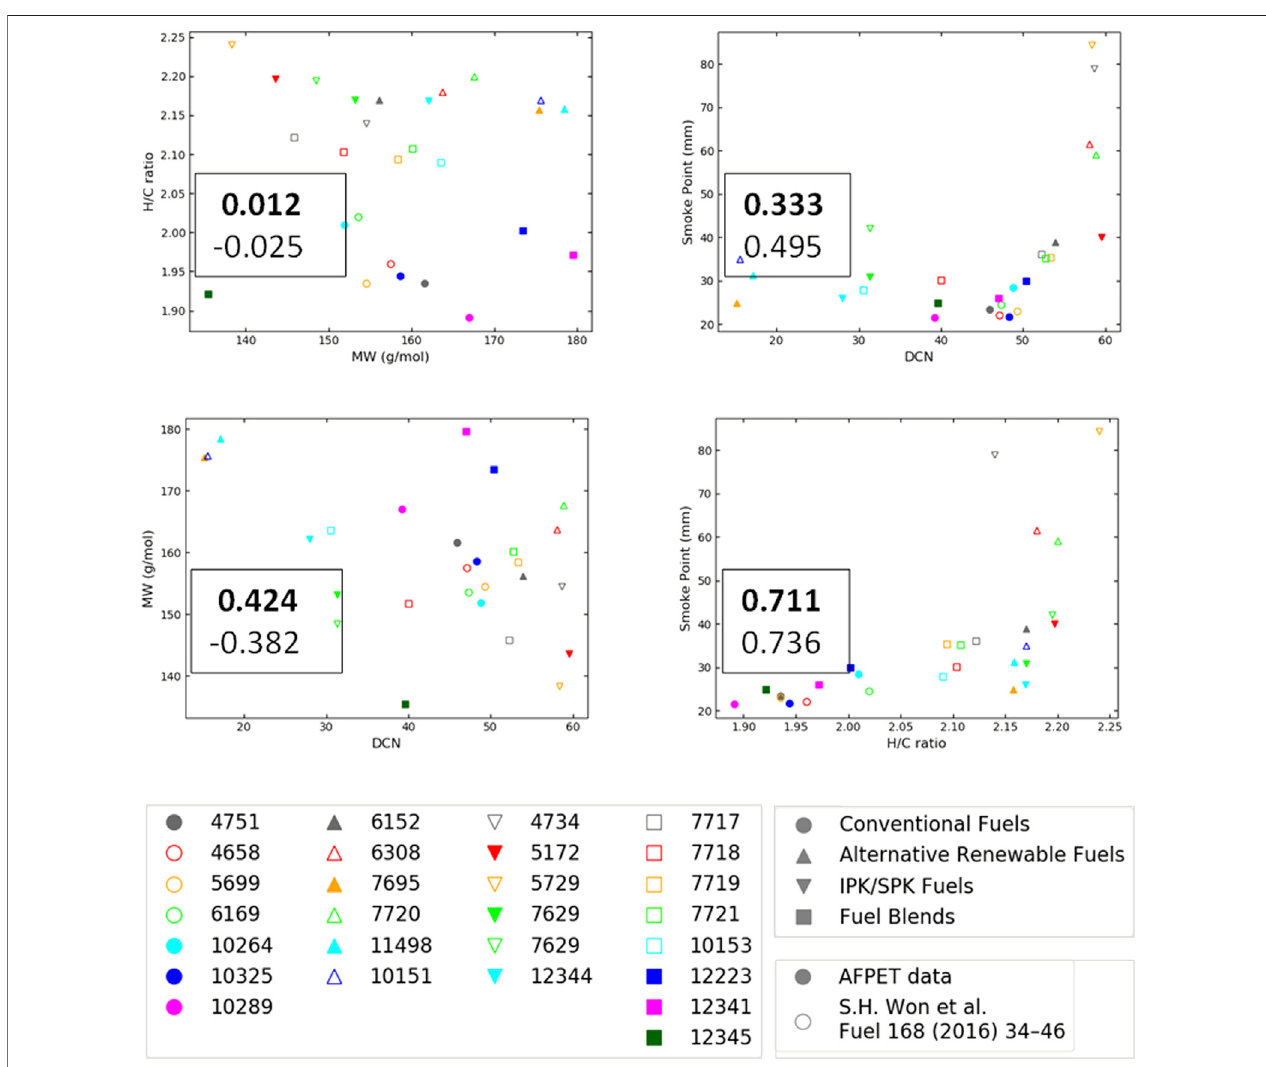
FIGURE 7 | Searching for correlations of fuel properties to emissions performance linking to speci fi c fuel compositional families (indicating the R 2 correlation coef fi cient: bold type set indicates solid data points, regular type set indicates hollow data points), clockwise from top left, molecular weight vs hydrogen/carbon ratio, DCN vs smoke point, smoke point vs H/C ratio and DCN vs molecular weight.